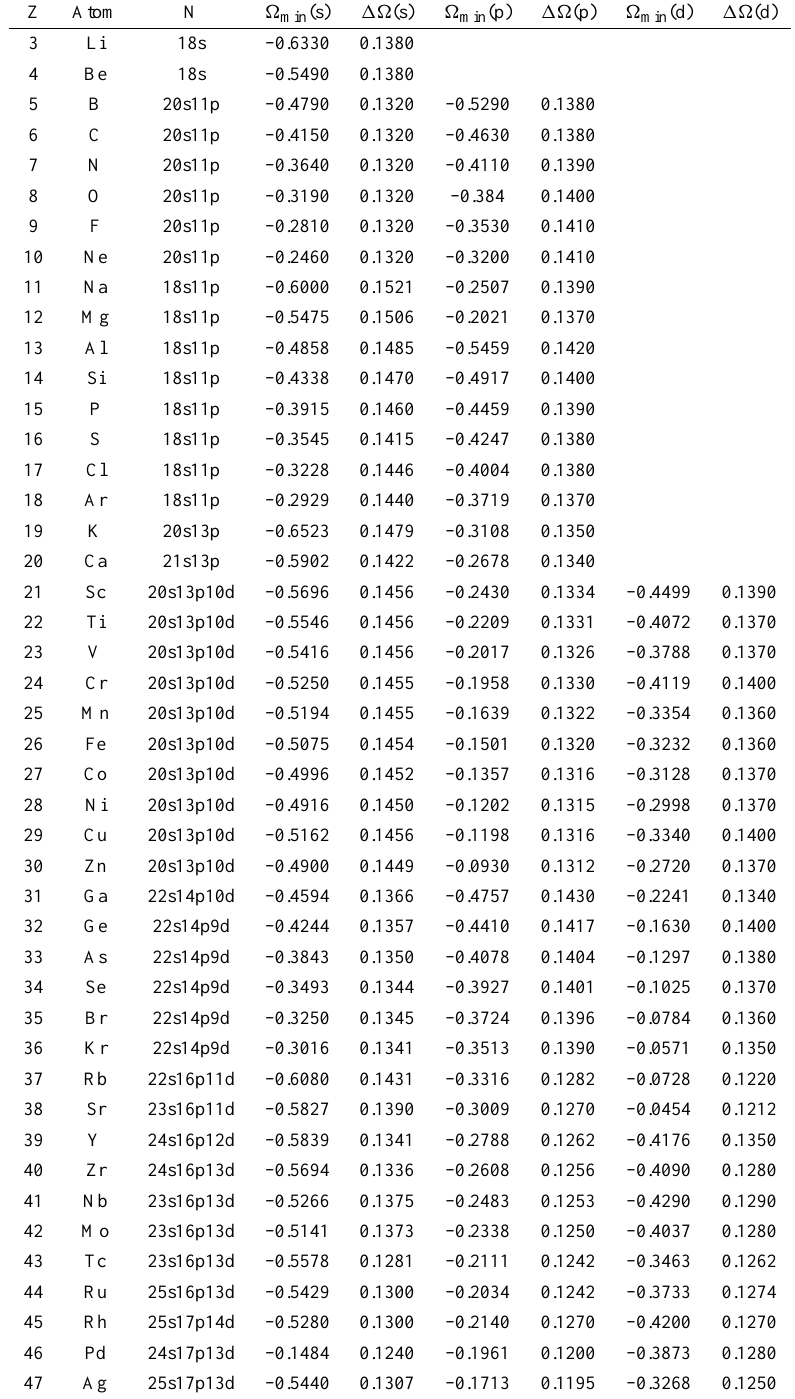
Discretization parameters of the adapted Gaussian basis sets